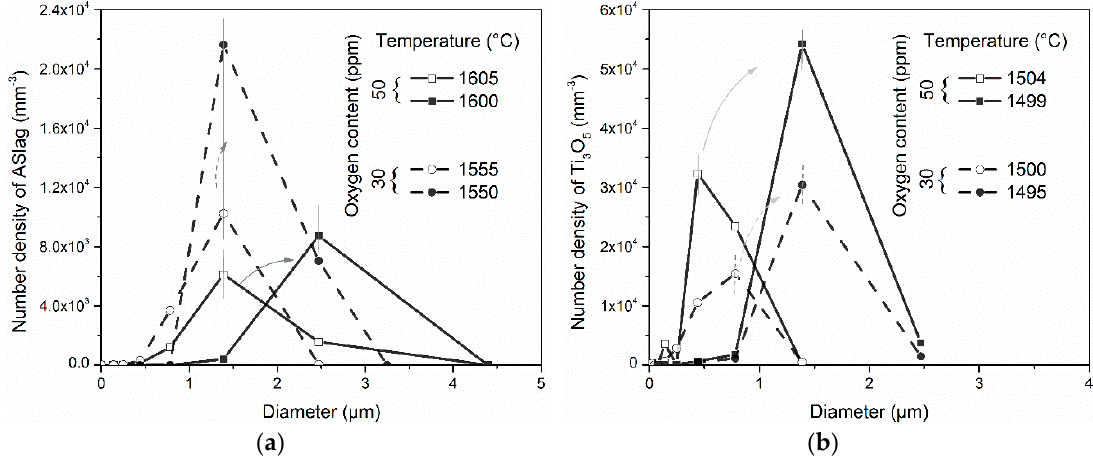
Figure 11. Illustration of the competitive nucleation and growth of ( a ) ASlag and ( b ) Ti 3 O 5 in the simulations with different oxygen contents.